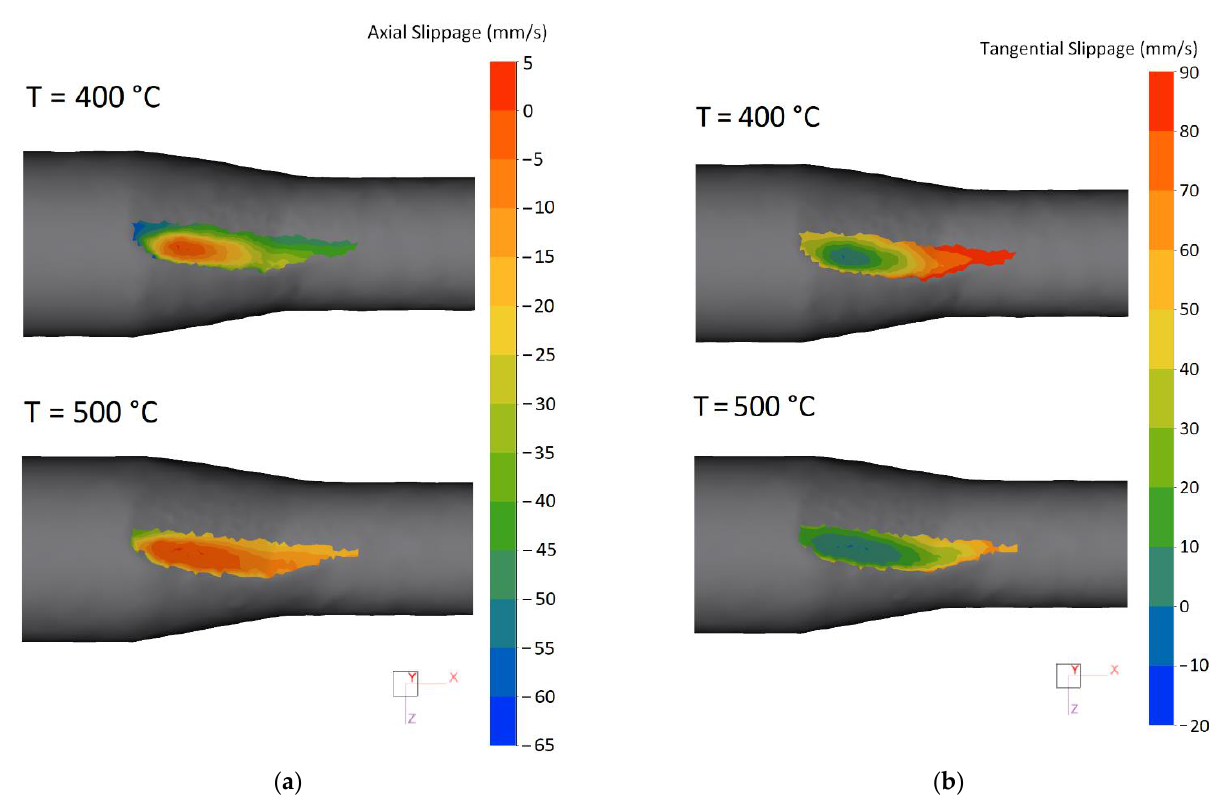
Figure 4. The field of ( a ) axial slippage and ( b ) tangential slippage on surface of workpiece contact with roll during RSR.